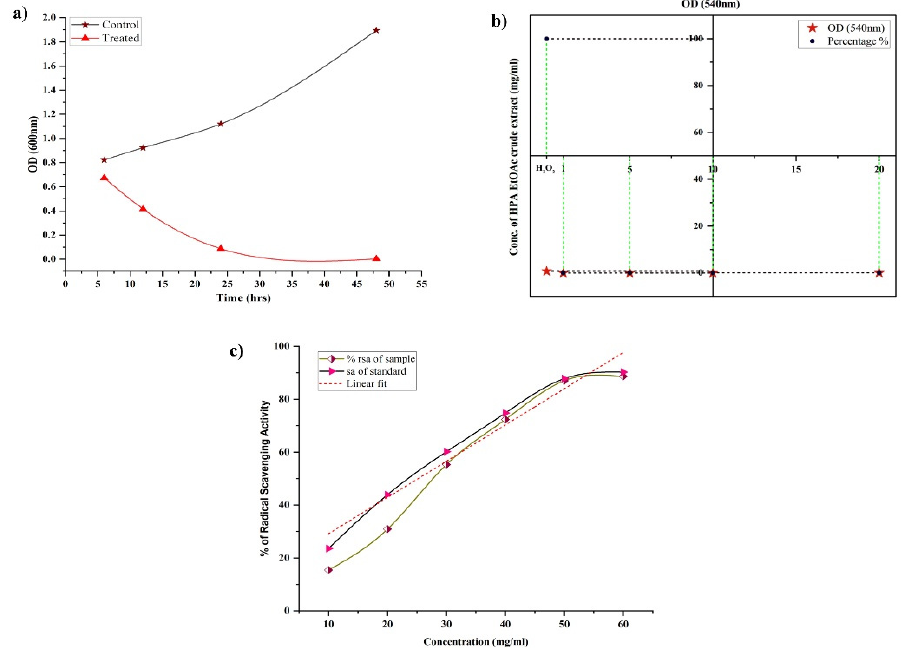
Figure 4. ( a ) Biofilm inhibition efficiency provided by HPAEtOAc crude extract on MRSA cells at 6, 12, 14, and 48 h at 570 nm OD between the control and treated MRSA cells at 150 µg/mL. ( b ) Anti-hemolytic activity of HPAEtOAc crude extracts on human erythrocytes up to 1–10 mg/mL, showing a non-hemolytic response. ( c ) Antioxidant activity of HPAEtOAc crude extracts using a DPPH free radicals scavenging assay, expressed as radical scavenging activity (RSA) vs. concentration of HPAEtOAc crude extract.